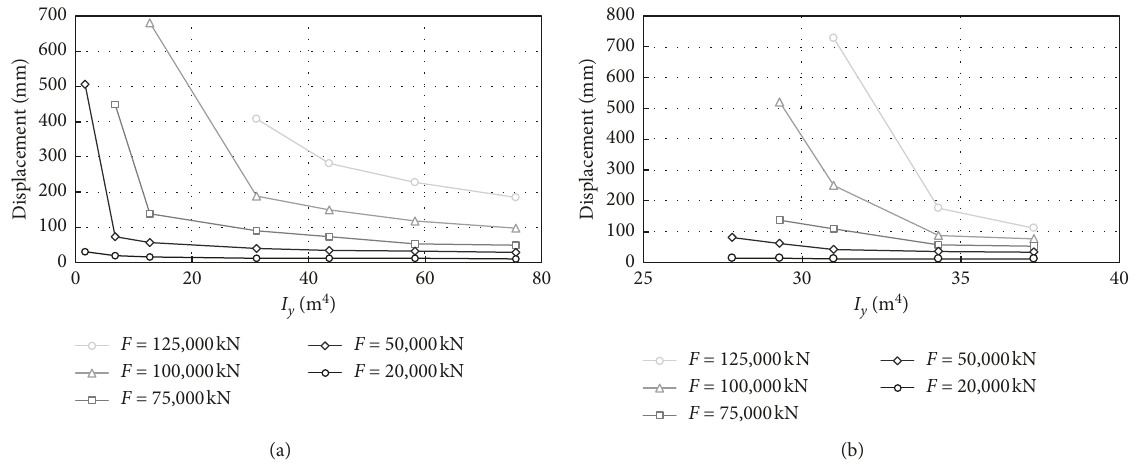
Figure 11: Analysis results for longitudinal displacements of substructure members. (a) Variation in sectional area. (b) Variation in reinforcement